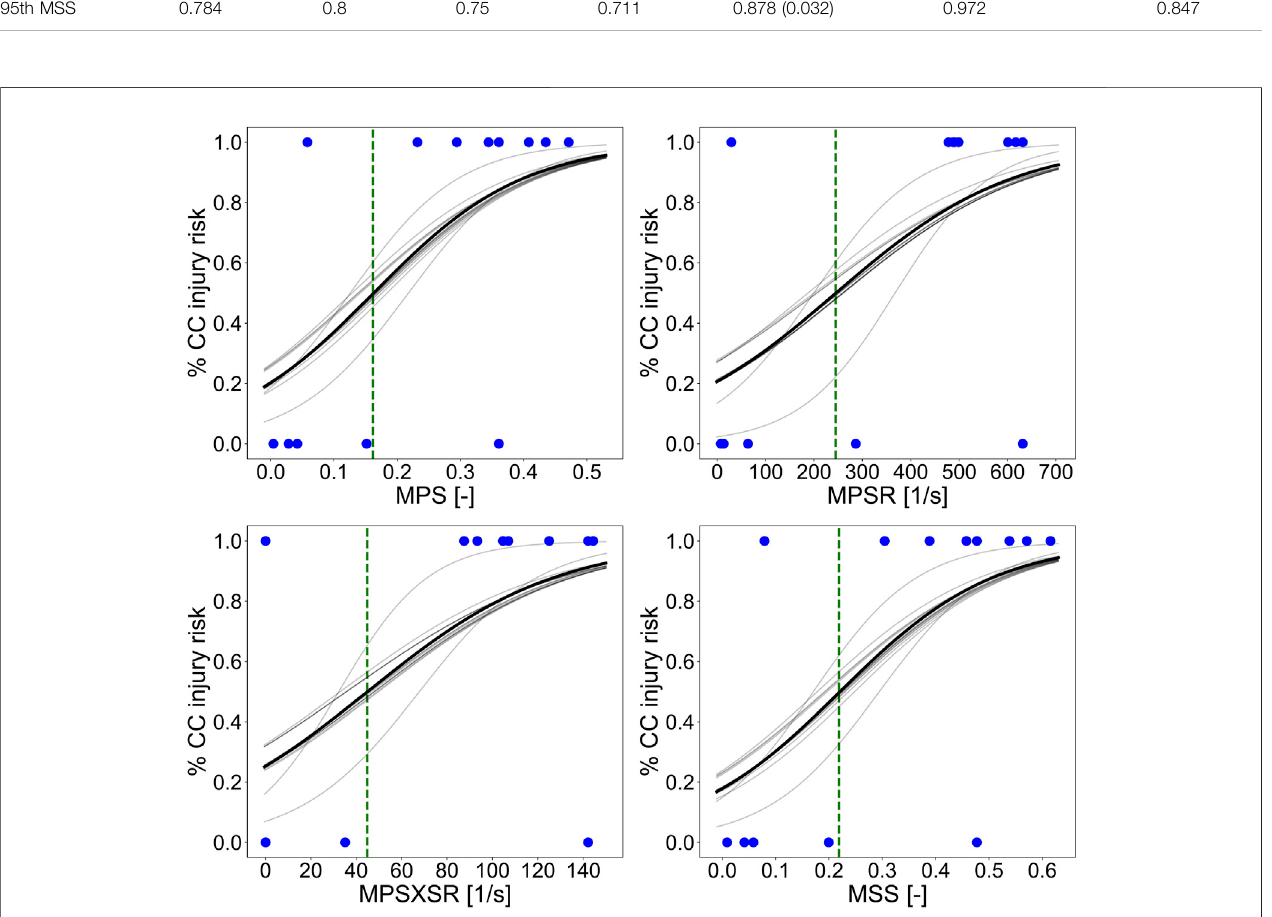
FIGURE 7 | Injury risk curves representing the probability of sustaining CC as a function of the 95th percentile of MPS, MPSR, MPSXSR, and MSS predicted with the porcine brain ML surrogate. The solid black line represents the logistic regression curve performed on the whole dataset. The light gray lines represent the logistic regression curves of each training dataset of the leave-one-out cross-validation procedure. The green vertical dashed lines indicate the thresholds corresponding to the 50% chance of CC (MPS (cid:1) 0.16, MPSR (cid:1) 245 s − 1 , MPSXSR (cid:1) 45 s − 1 , and MSS (cid:1) 0.22), while the blue dots represent the experimental data (cortical damage (cid:1) 1 and no damage (cid:1) 0) collected by means of the MR and histology assessments post-CCI.